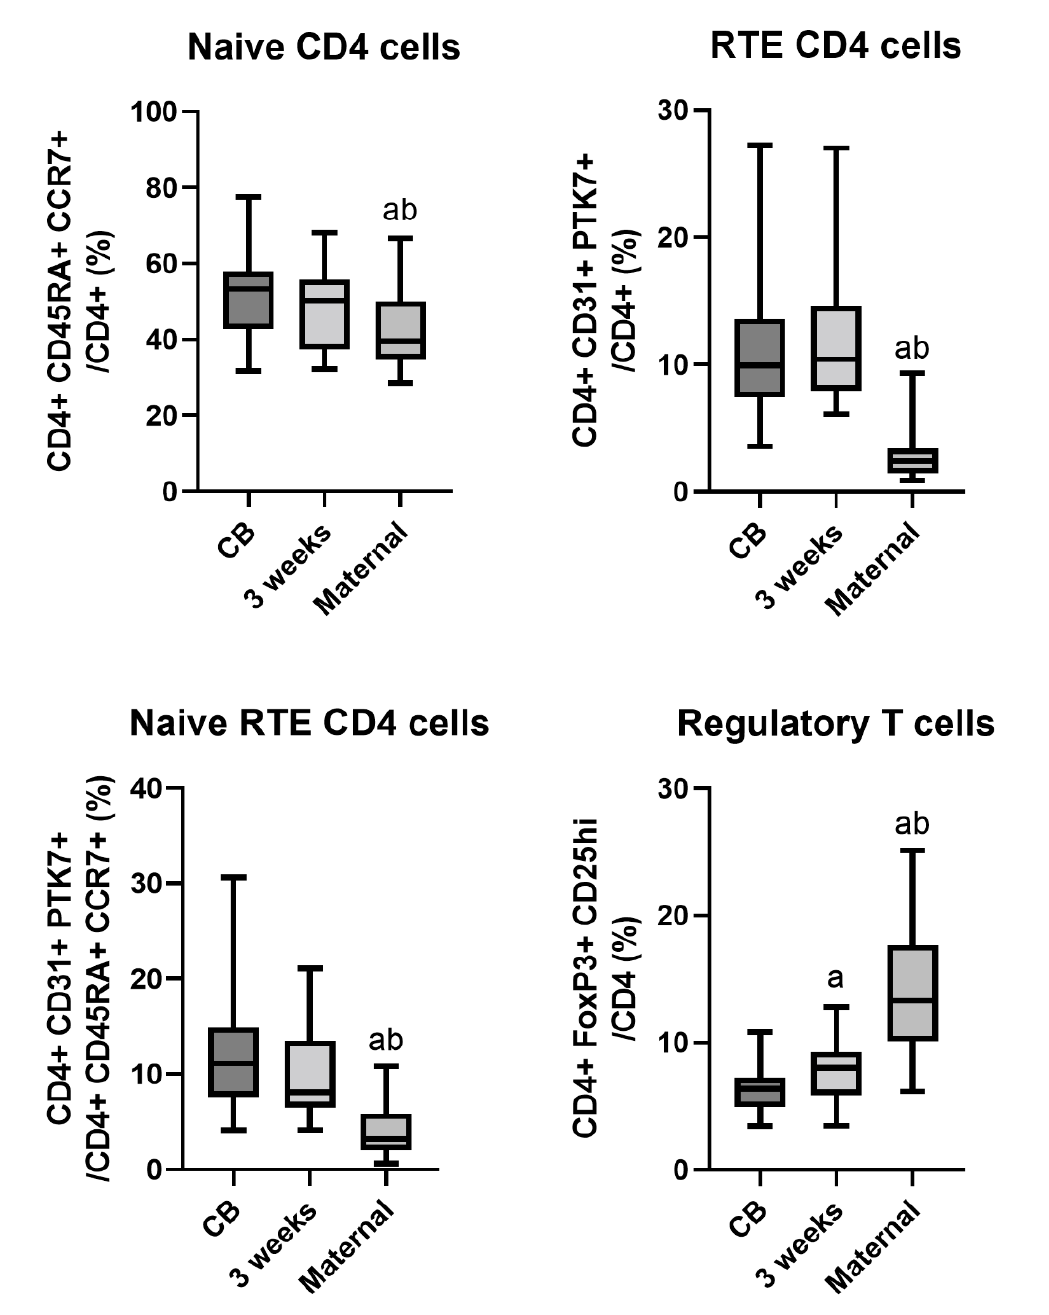
4 of 8 Table 1. Anthropometric and pregnancy characteristics of participating neonates and mothers. Data are presented as median [range] or ratio. All Neonates n = 19